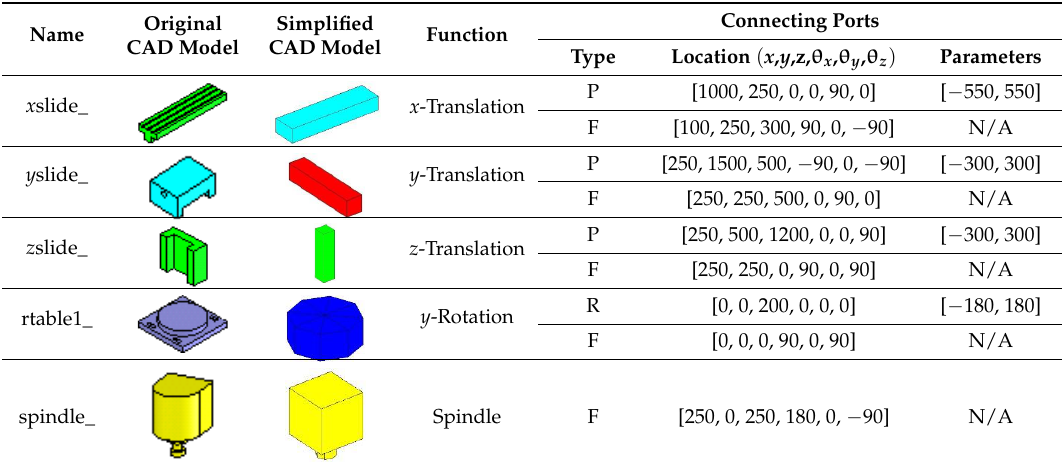
Table 5. Results of module component simplification.